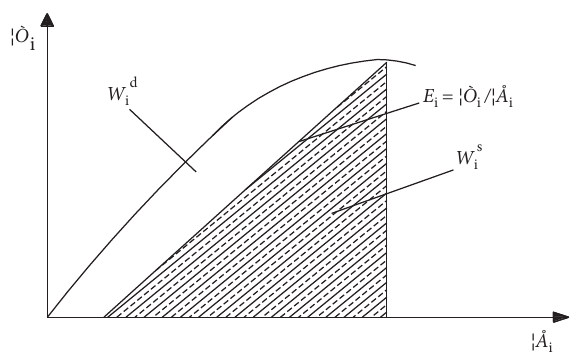
Figure 7: The relationship between elastic strain energy and dissipated energy in the rock unit.